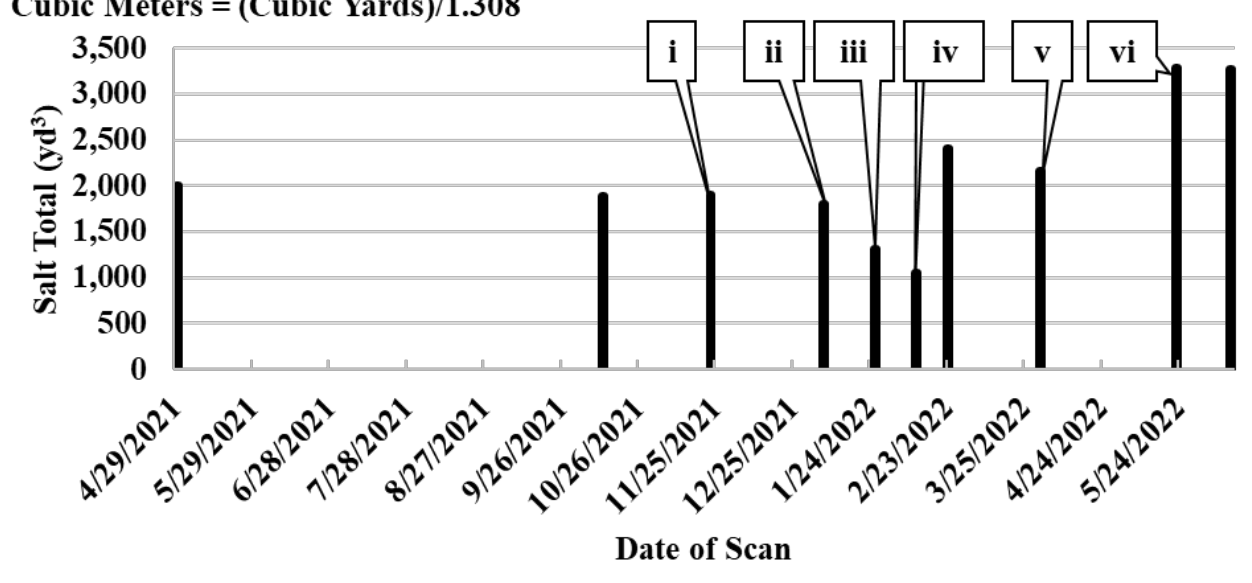
Figure 6. Total salt over the winter season in the Lebanon, Indiana salt facility.